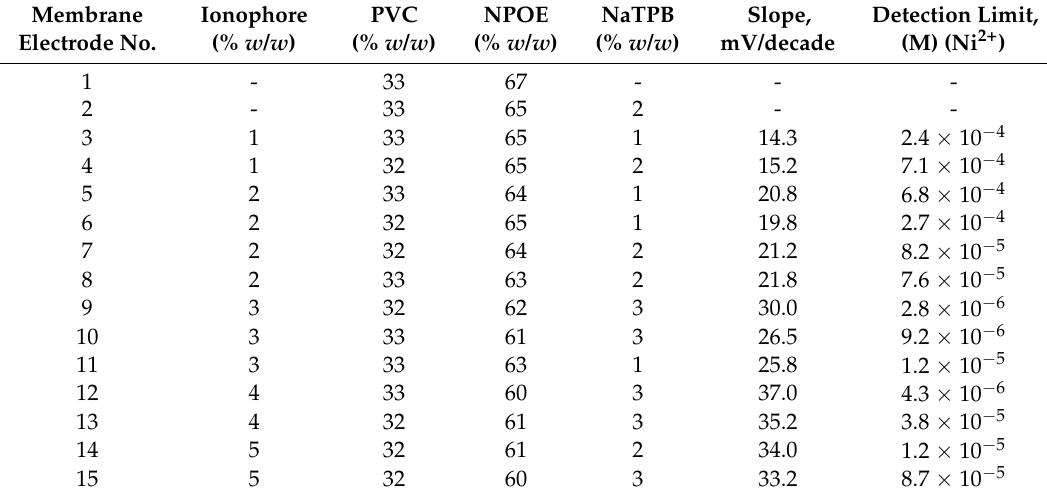
Table 2. Optimization of membrane components for Ni 2+ ISE based on triphenylamine derivative. Membrane Electrode